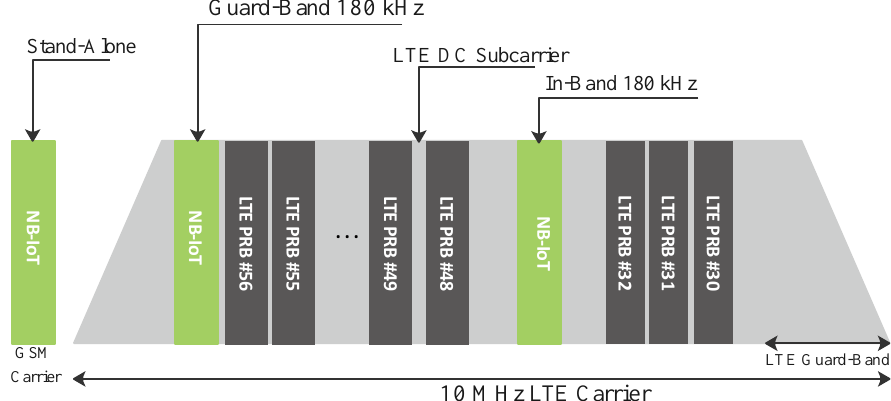
Figure 12. NB-IoT modes of deployment.